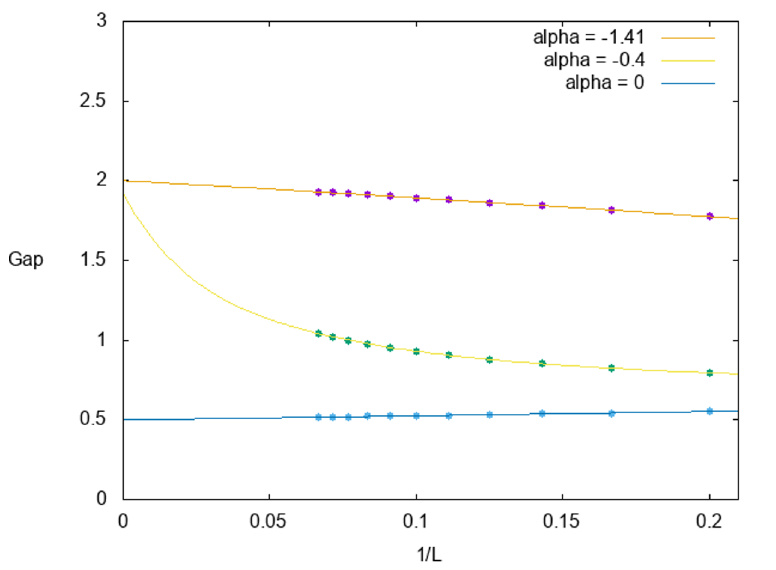
Figure 24 . The blue line corresponds to the case α = 0 . As expected, we see that the first gap over the ground state converges to h = 1 since in this case the full generating function is given by 2 the sum of the two string functions c m =0 + c m =2 . The orange line corresponds to α = − 1 ; in l =0 l =0 cos γ this case, we see that the first gap converges to h = 2 since the generating function in this case is given only by the string function c m =0 . The yellow line corresponds to a perturbation of α away l =0 from zero, (in the figure we take α = − 0 . 364 ). We see that in this case the gap also converges to 2 , but it converges much more slowly than the case α = − 1 : this is compatible with an RG flow cos γ away from the non-compact theory with α = 0 , towards the compact theory with α = − 1 cos γ